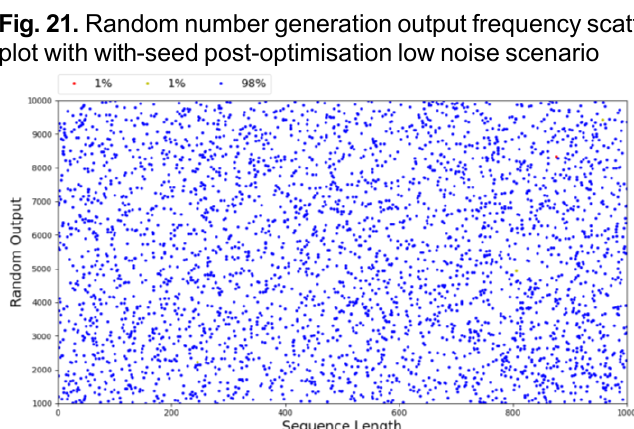
Fig. 19. Random number generation output frequency scatter plot with with-seed pre-optimisation low noise scenario I